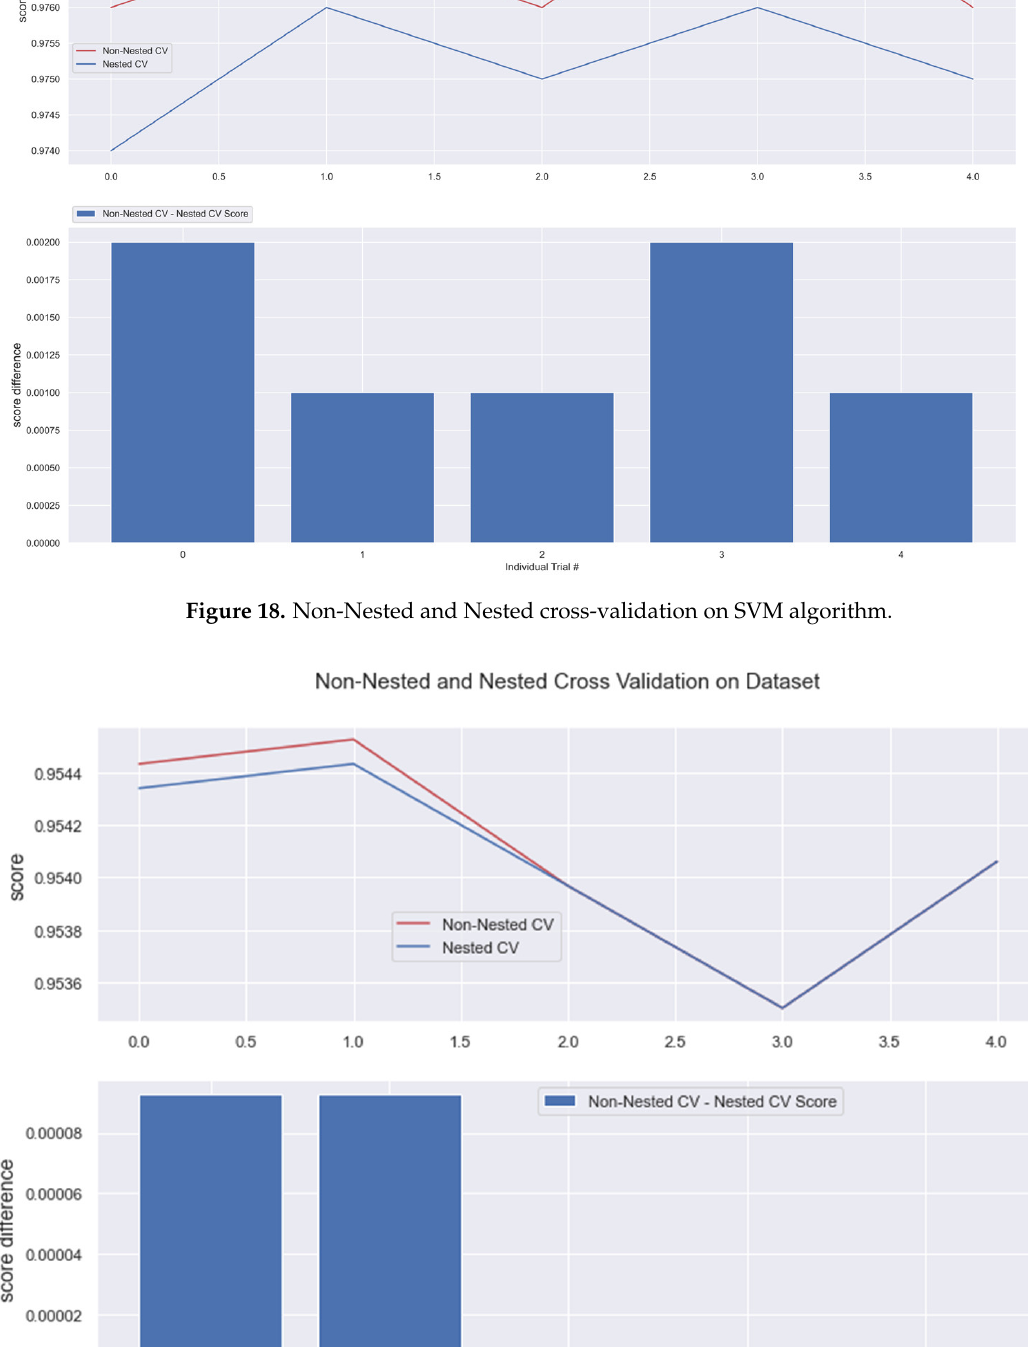
Figure 19. Non-Nested and Nested cross-validation on RC algorithm.